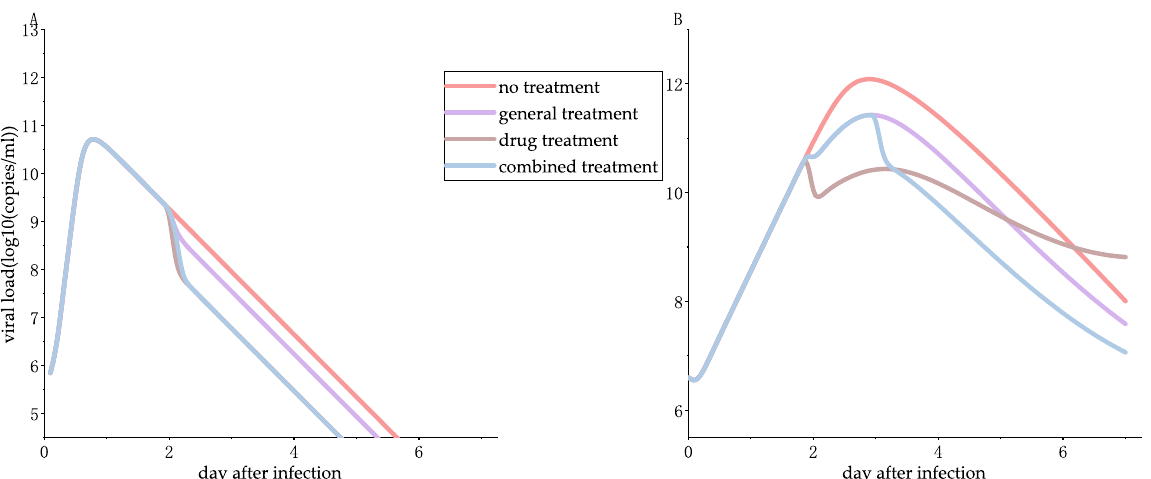
Figure 9. Changes in the viral load without treatment and following general treatment, drug treatment, and combined treatment: ( A ) mild patients (combined treatment refers to general treatment and drug treatment starting the day after infection); ( B ) severe patients (combined treatment refers to general treatment starting the day after infection and drug treatment starting the third day after infection).